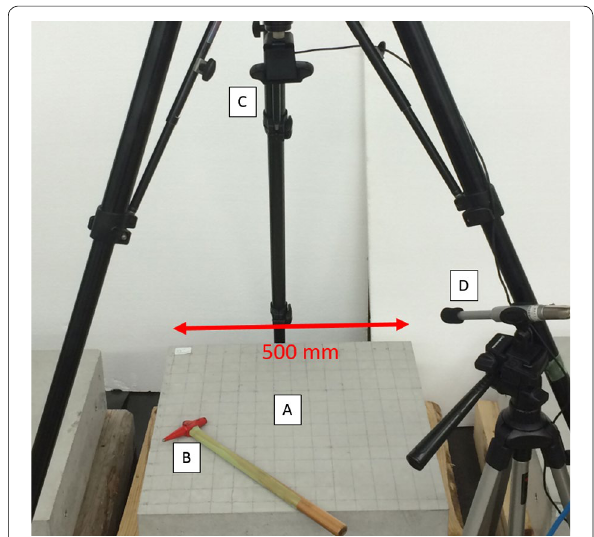
Fig. 5 Experimental setup: concrete test block ( A ), hammer with red head for position recognition by image processing ( B ), web camera ( C ) and microphone ( D )